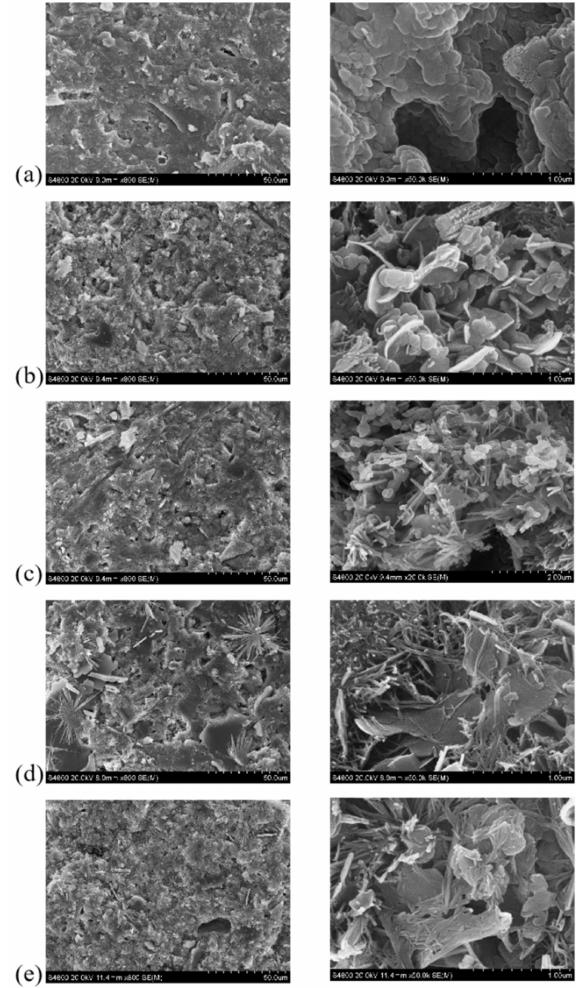
Figure 11. Microstructure of cement stone under different curing temperatures and pres- sures: ( a ) 25 ◦ C—0 MPa, ( b ) 50 ◦ C—10 MPa, ( c ) 80 ◦ C—20 MPa, ( d ) 110 ◦ C—30 MPa, and ( e ) 140 ◦ C—40